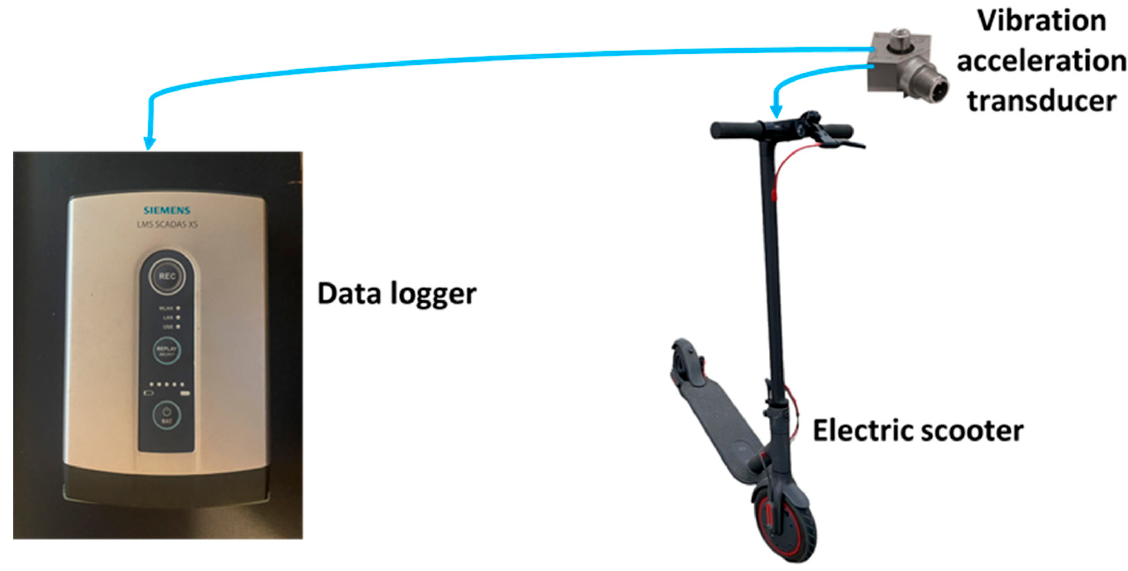
Figure 2. Diagram of the installation of the measuring sensor and the recording system.